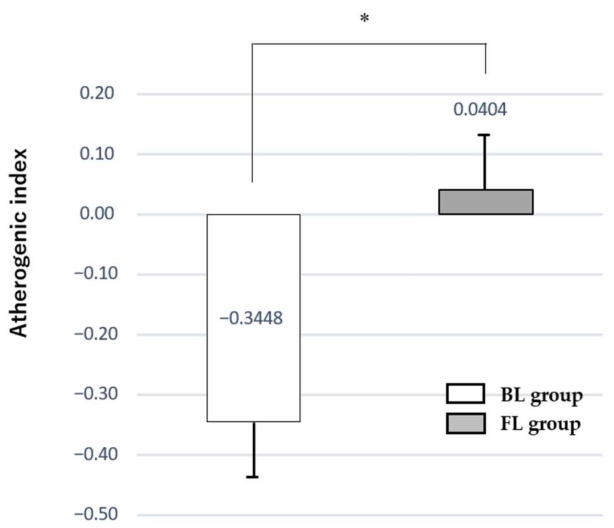
Figure 2. Comparison of Changes from the baseline in Atherogenic index (AI) in the FL and BL after 4-week intervention. AI: Non-HDL-cholesterol/HDL-cholesterol, there was significant group difference between the FL and BL group in changes in AI. *: p =